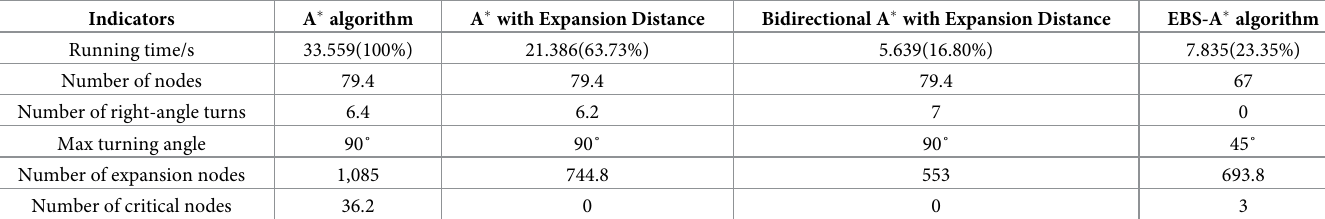
Table 2. Average simulation results of four algorithms on randomized 50 × 50